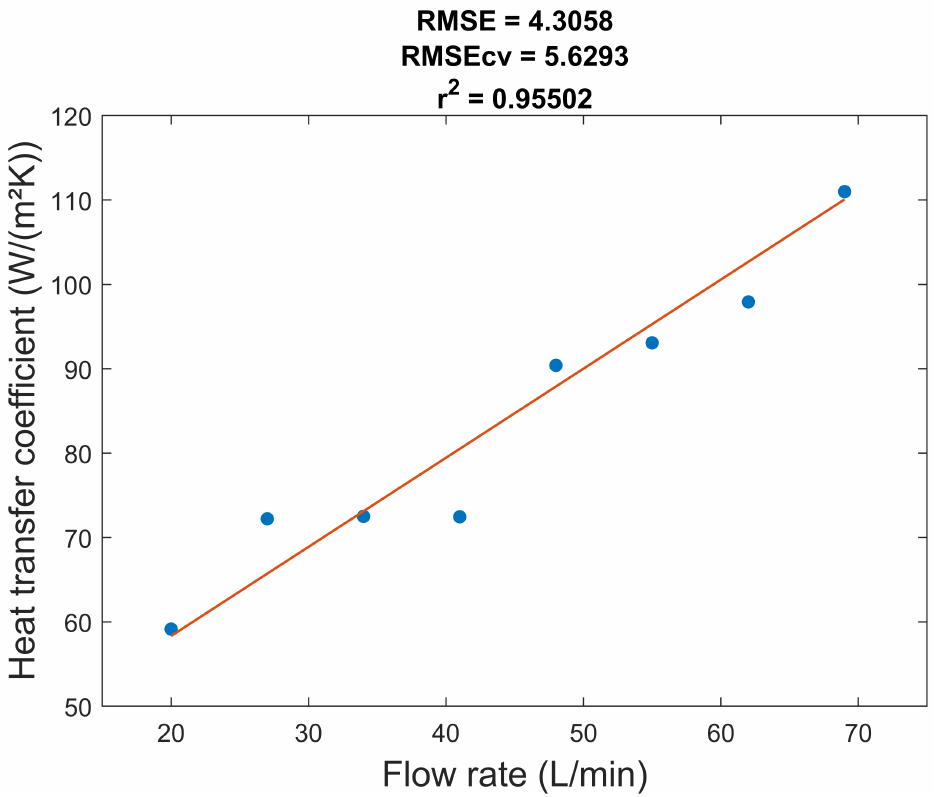
Figure 5. Linear regression model of volumetric gas flow rate in function of the heat transfer coeffi- cient. The blue dots indicate experimental data, and the red solid line indicates the linear regression model. The linear regression had a slope of 71.11 E3 J/(m 5 K) and an intercept of 32.05 W/(m 2